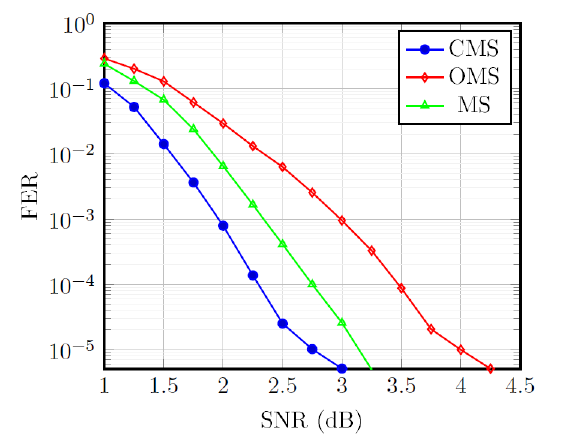
Figure 10. Decoding performance of the QC-LDPC decoders on the N = 3808, R = 1/3 for base matrix BG1 of 5G NR.